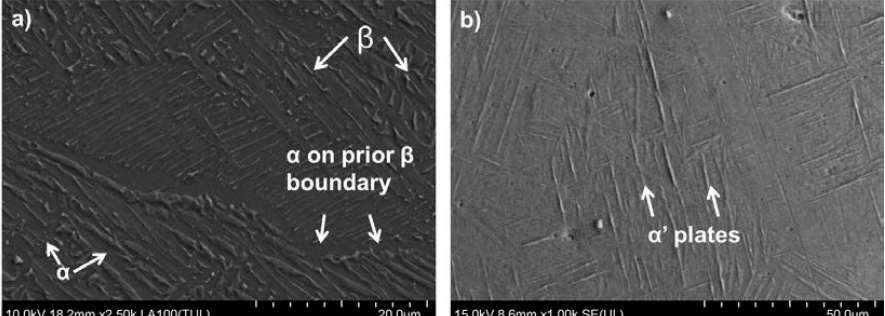
Figure 5. SEM micrographs of ( a ) the EBM-fabricated sample in BSE mode and ( b ) the SLM-fabricated sample in topographical mode.